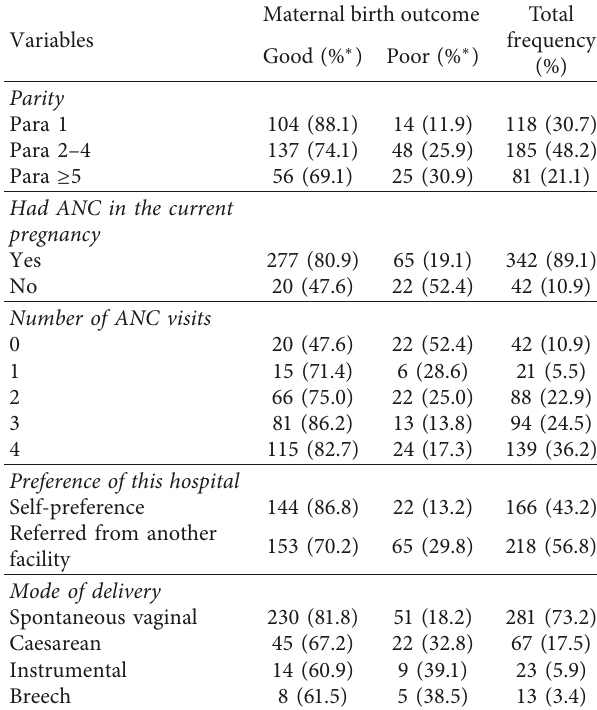
Table 2: Frequency distribution of obstetric variables cross-tab- ulated with maternal birth outcome, among postnatal mothers in Debre Tabor Hospital, 2016 ( n � 384).